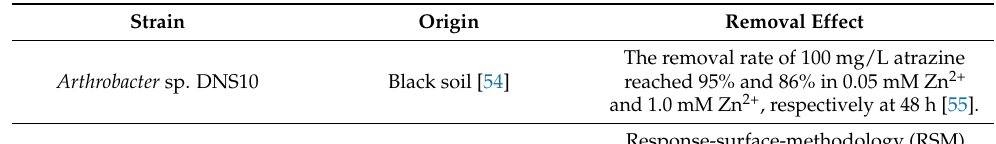
Table 5. Microbial degradation of aqueous